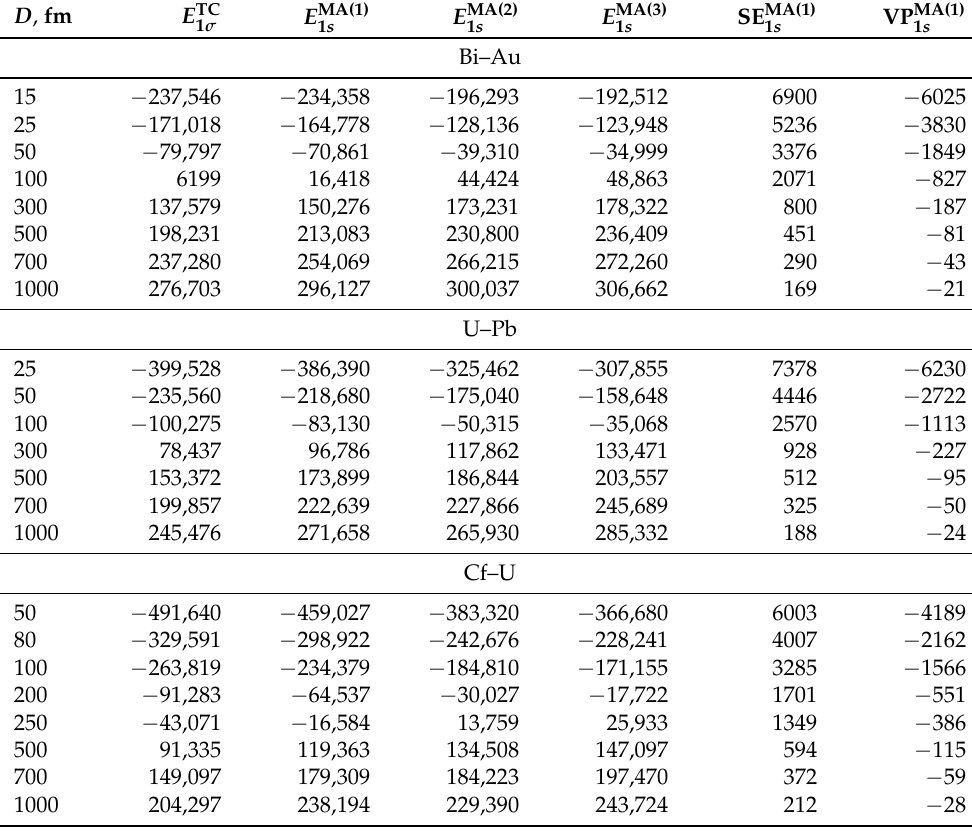
Figure 2. The ground-state binding energies (in eV) for the U–Pb quasimolecule from Ref. [35] relative to the results obtained in the present work, ∆ E = E Ref.[35] Table 1. The ground-state Dirac energy, self-energy, and vacuum polarization contributions (in eV) for the one-electron Bi–Au, U–Pb, and Cf–U quasimolecules at different internuclear distances. D ,